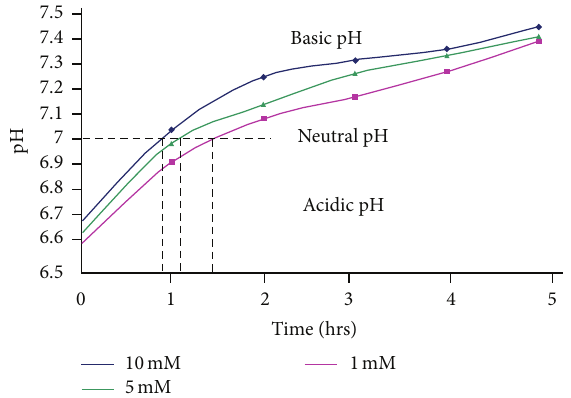
Figure 6: Change in pH of the reaction bath over a period of 5 hours during the growth of ZnO nanorods (reproduced with the permission from